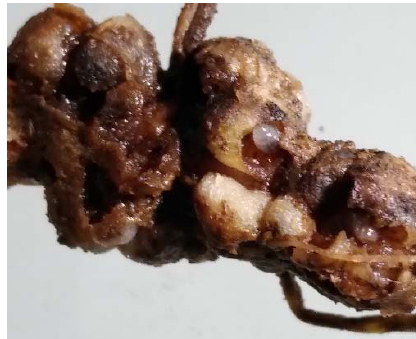
Figure 4. Lupin root nodules damage.